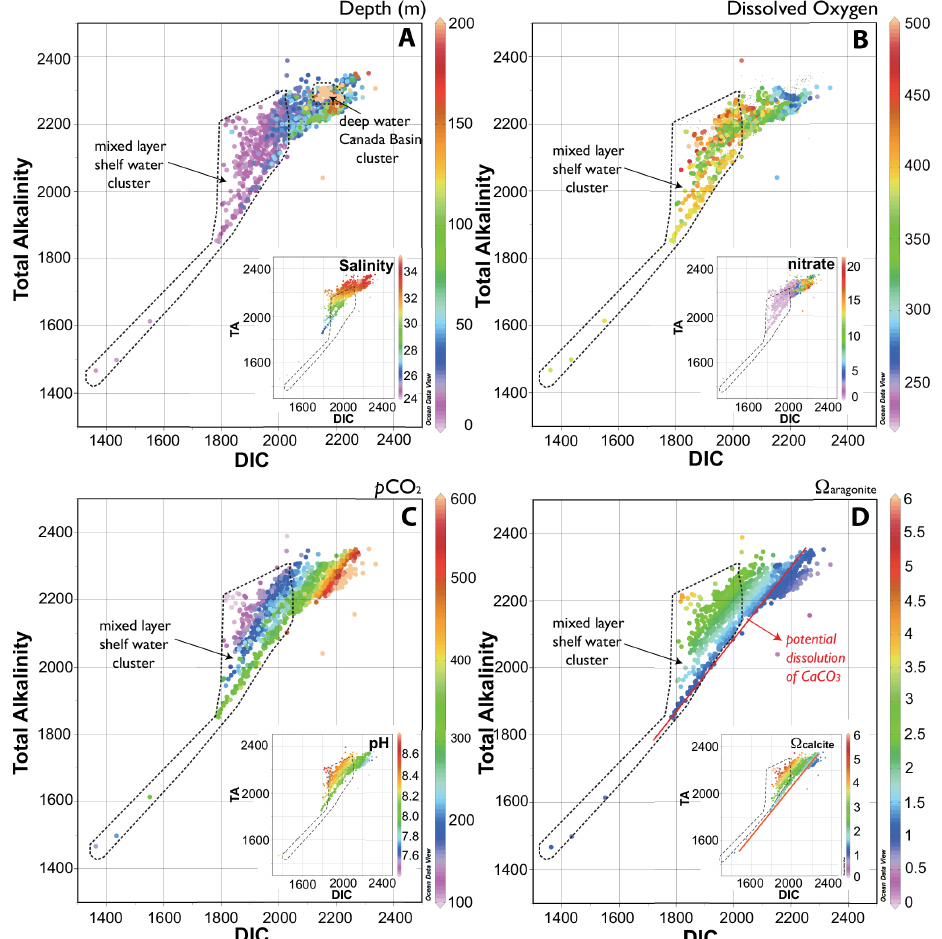
Figure 3. Seawater CO 2 –carbonate chemistry and marine biogeochemistry of the 2010 and 2011 ICESCAPE cruises. (a) DIC (µmolkg − 1 ) versus total alkalinity (TA;µmolkg − 1 ) with range of colour denoting depth (in metres), with salinity shown in the inset. The depth of samples collected below 200m is not differentiated colourwise, and represents water depth to > 4000m. With this in mind, the approximate range of deep water (Canada Basin) hydrographic properties are shown within the light dashed line. Approximate cluster of shelf mixed-layer water is shown here and in all panels and insets. (b) DIC (µmol kg − 1 ) versus total alkalinity (TA;µmolkg − 1 ) with range of colour denoting dissolved oxygen (µmolkg − 1 ) with nitrate (µmolkg − 1 ) shown in the inset. (c) DIC (µmol kg − 1 ) versus total alkalinity (TA;µmolkg − 1 ) with range of colour denoting p CO 2 (µatm) with pH (no units) shown in the inset. (d) DIC (µmolkg − 1 ) versus total alkalinity (TA; µmolkg − 1 ) with range of colour denoting saturation state ( (cid:127) ) for aragonite (no units) with (cid:127) calcite (no units) shown in the inset. The red line denotes (cid:127) values of 1 with potential dissolution of CaCO 3 minerals below a (cid:127) value of